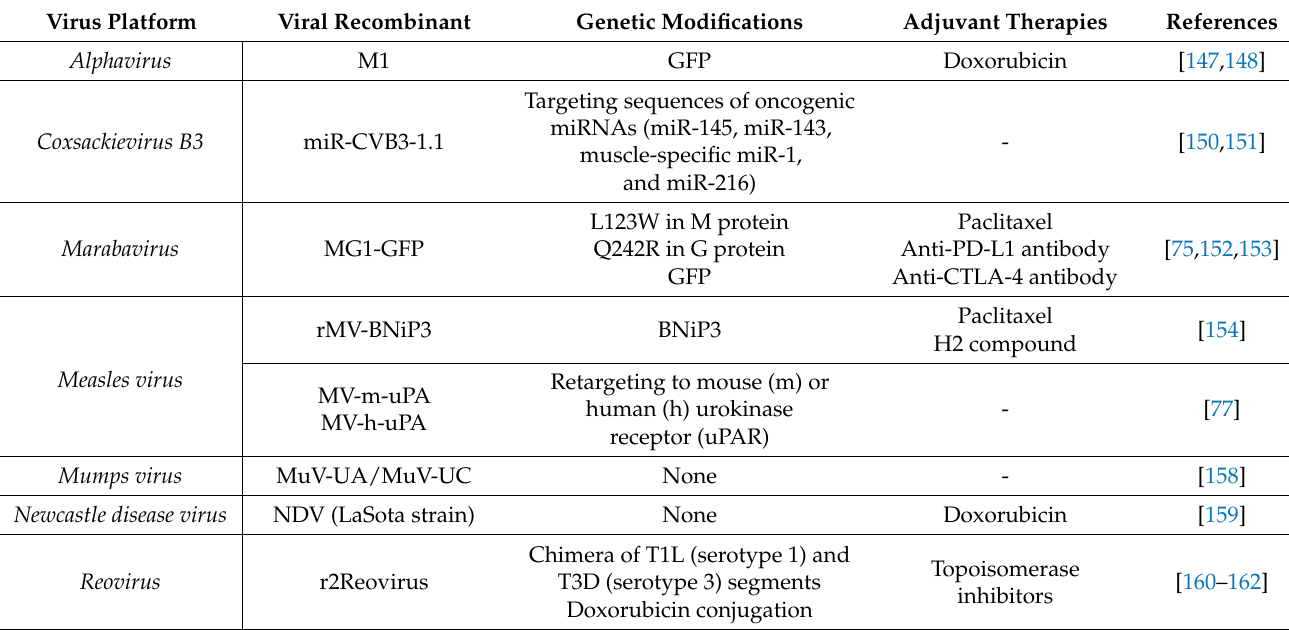
Table 2. RNA viruses preclinically tested in vitro and in vivo against